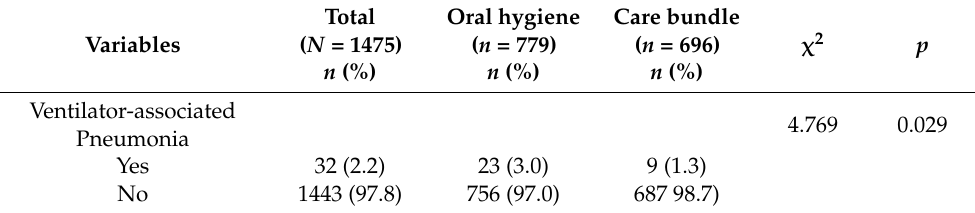
Table 2. The Incidence of Ventilator-Associated Pneumonia ( N =